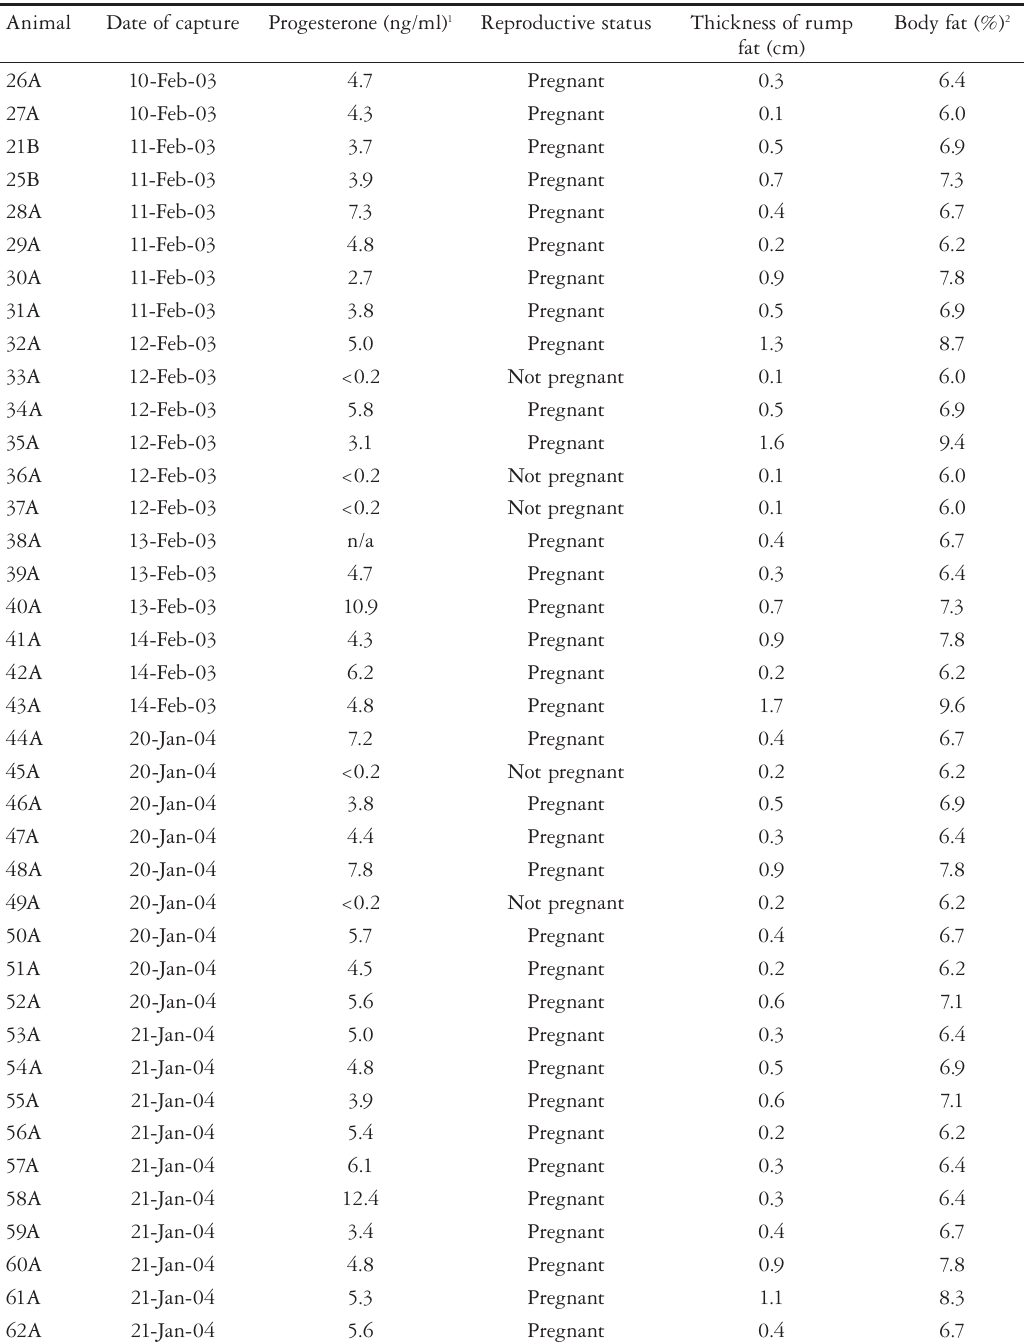
Table 1. Reproductive status and ultrasound estimates of rump fat for female woodland caribou in the Greater Besa- Prophet Area in northern British Columbia, 2003–2004. Reproductive status for 38A was confirmed via necropsy and 33A was <1.5 years